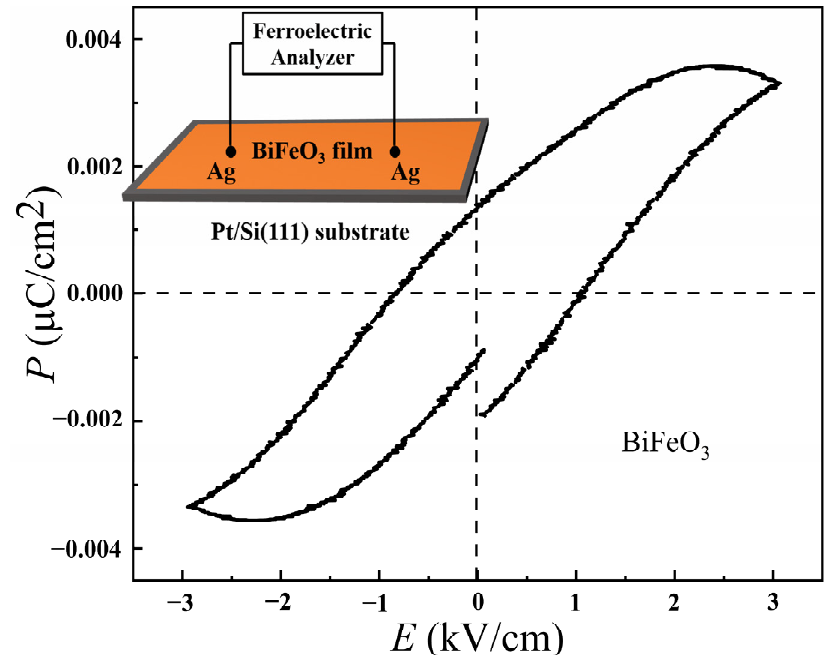
Figure 2. Ferroelectric hysteresis loop. Inset: schematic diagram of the test circuit.